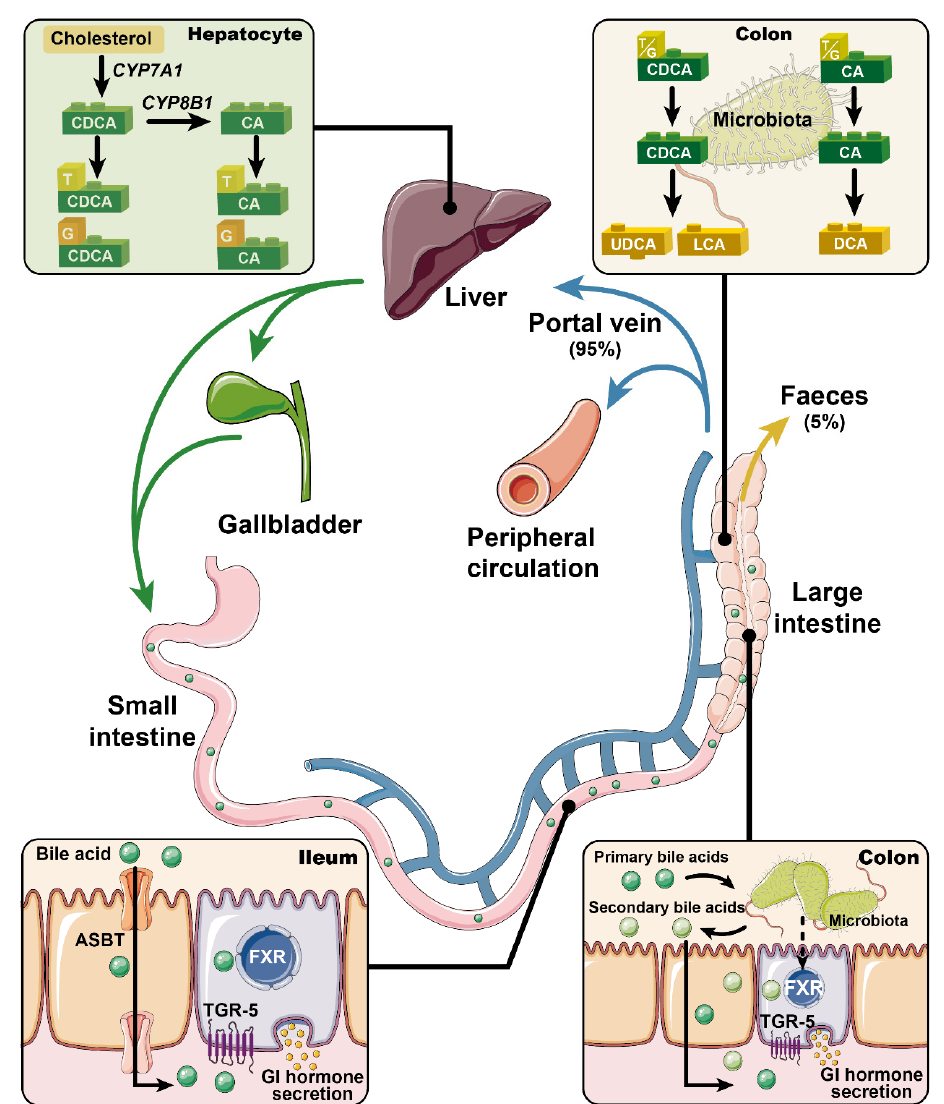
Figure 1. Primary bile acids (i.e., chenodeoxycholic acid (CDCA) and cholic acid (CA)) are synthesized from cholesterol in the liver, and conjugated to glycine and taurine prior to their secretion into bile. In response to meals, bile acids are discharged into the intestine. Approximately 95% of the intestinal bile acids are absorbed in the ileum via apical sodium bile acid co-transporter (ASBT) and return to the liver for re-secretion (i.e., the enterohepatic circulation). Only ~5% of bile acids escape into the large intestine and are modified by gut microbiota into secondary bile acids (e.g., deoxycholic acid (DCA), lithocholic acid (LCA), and ursodeoxycholic acid (UDCA)). Bile acids are now recognized as pivotal signaling molecules that participate in the regulation of metabolic homeostasis through regulating the secretion of gastrointestinal hormones. This complex process has been linked to activation of the nuclear farnesoid X receptor (FXR) and/or the membrane Takeda G-protein-coupled receptor 5 (TGR5). Accordingly, modulation of FXR and/or TGR5 signaling has been actively pursued for the management of metabolic disorders.